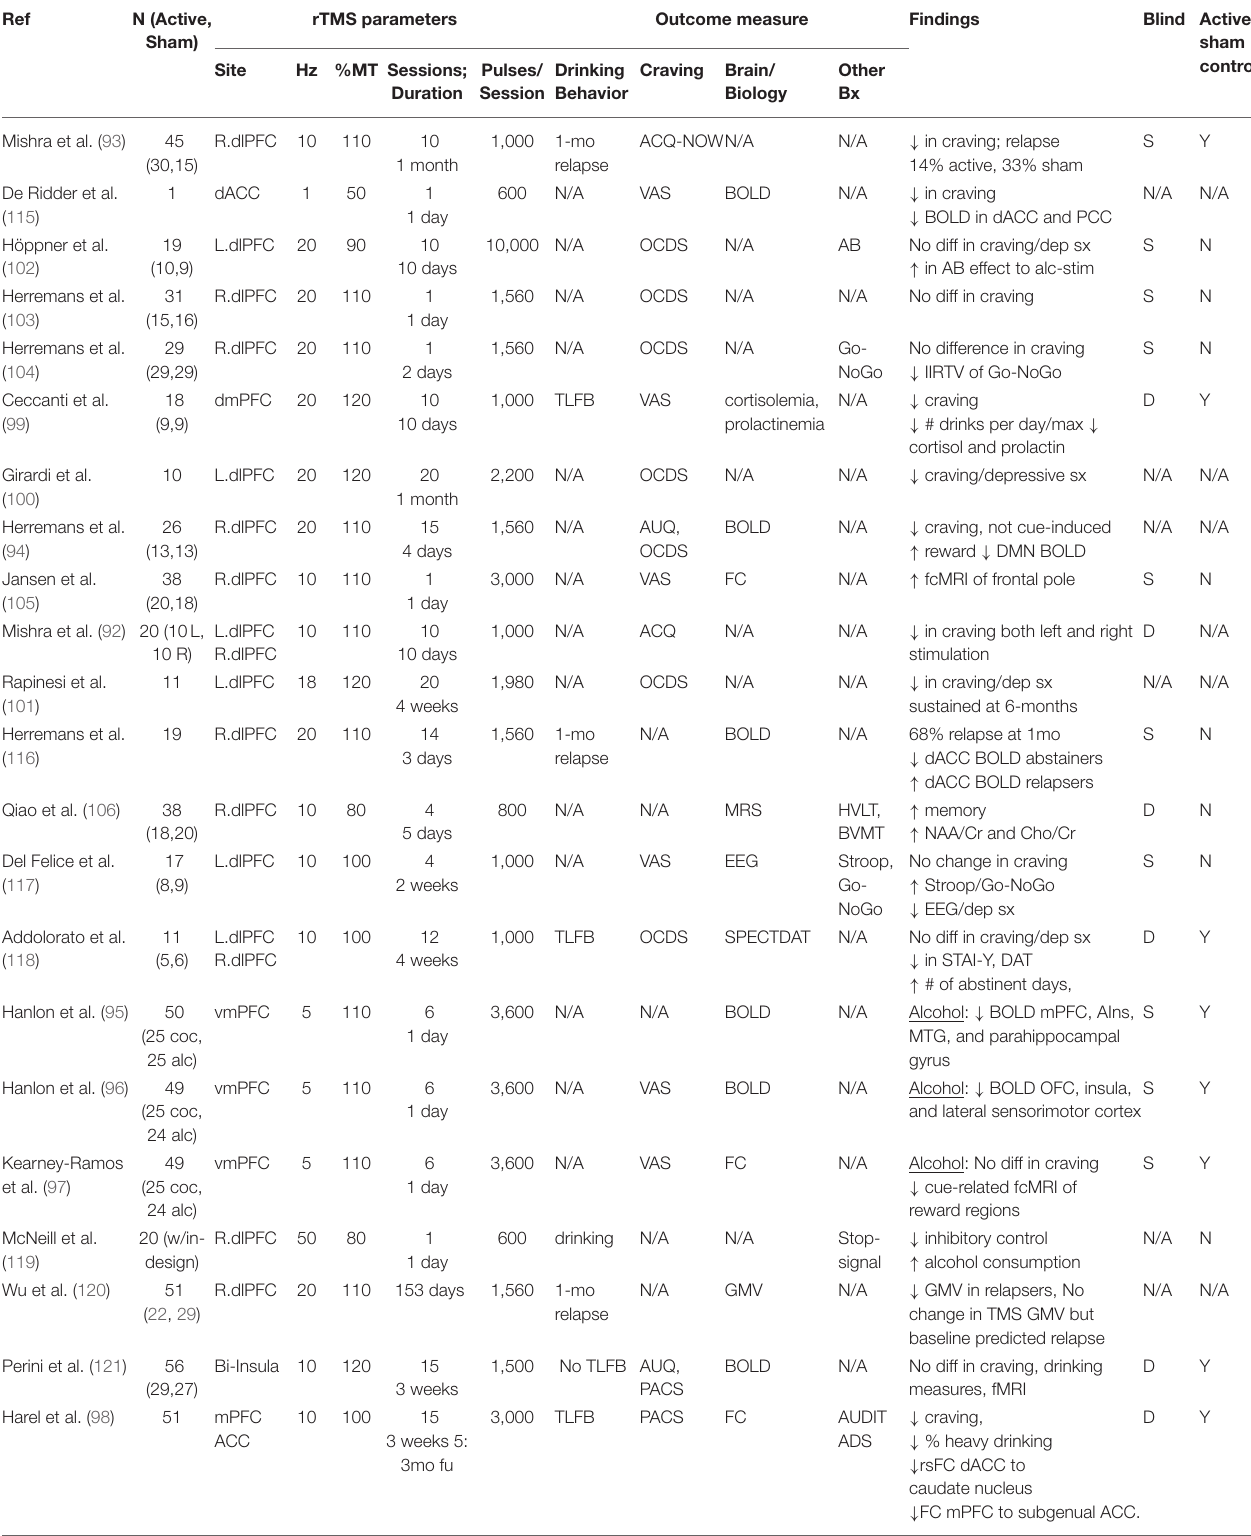
TABLE 1 | Summary of all transcranial magnetic stimulation (TMS) studies in alcohol use disorder (AUD) to date. Ref rTMS parameters Outcome measure Findings Blind Active